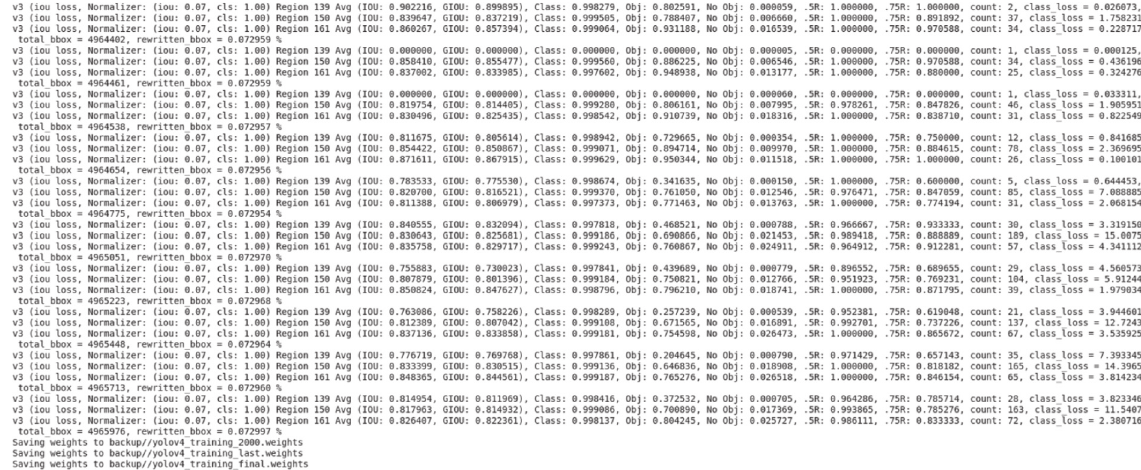
Figure 4: Model on Google Colab.